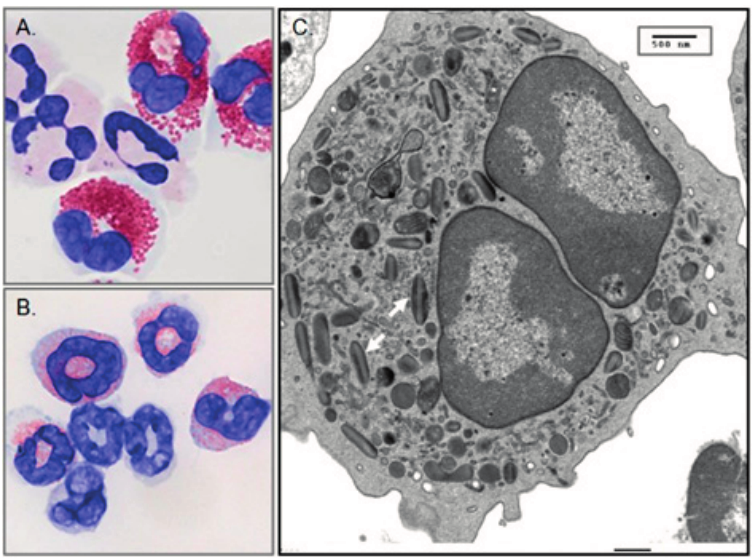
Figure 1. Human and mouse eosinophils. ( A ) Human eosinophils from peripheral blood exhibit characteristic bilobed nuclei and large red-stained cytoplasmic secretory granules; ( B ) Eosinophils isolated from the spleen of an interleukin-5 transgenic mouse. Cells in panels ( A , B ) were stained with the modified Giemsa protocol. Cells with multi-lobed nuclei and without large granules are neutrophils; original magnification, 100×; ( C ) Transmission electron micrograph of a mouse eosinophil. Two of the cytoplasmic secretory granules are indicated by white arrows just to the left of the lower lobe of the nucleus. The central core of the eosinophil specific granule contains the cationic major basic protein (MBP). The remaining major cationic proteins, including EDN, ECP and EPX, as well as cytokines, chemokines, growth factors and enzymes are localized in the peripheral portion of the granule; original magnification 6000×. Reprinted from [1] with permission from Nature Publishing